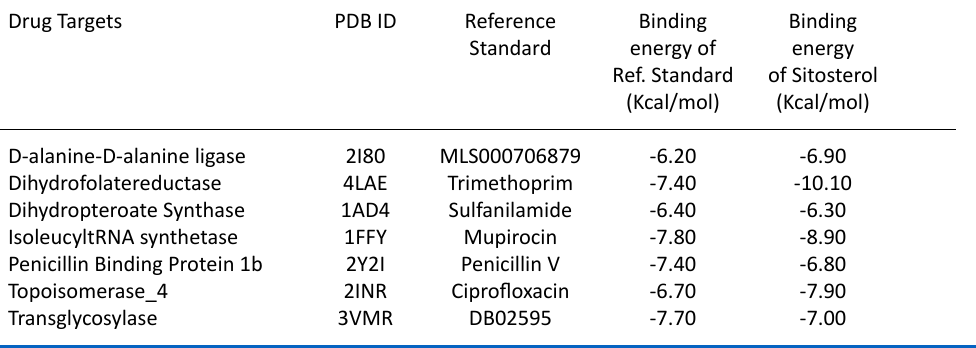
Table 5. Results of molecular docking analysis of β-Sitosterol and potential drug targets Drug Targets PDB ID Reference Binding Binding Standard energy of